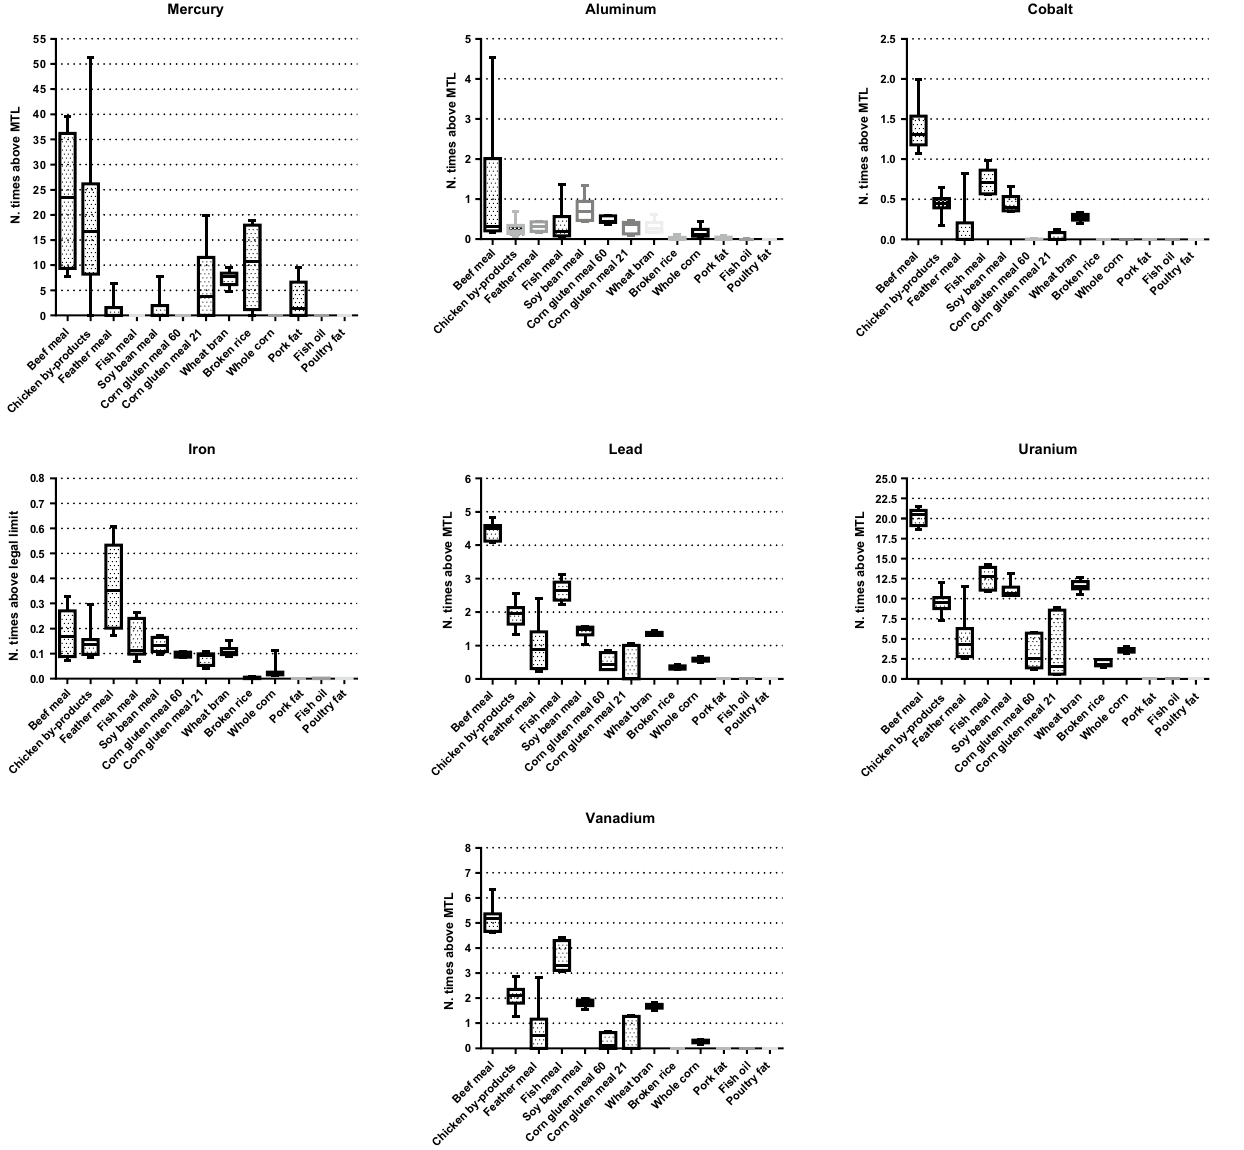
Figure 5. Number of times above maximum tolerated level (MTL) and/or legal limit for toxic metals in ingredients of animal and vegetable